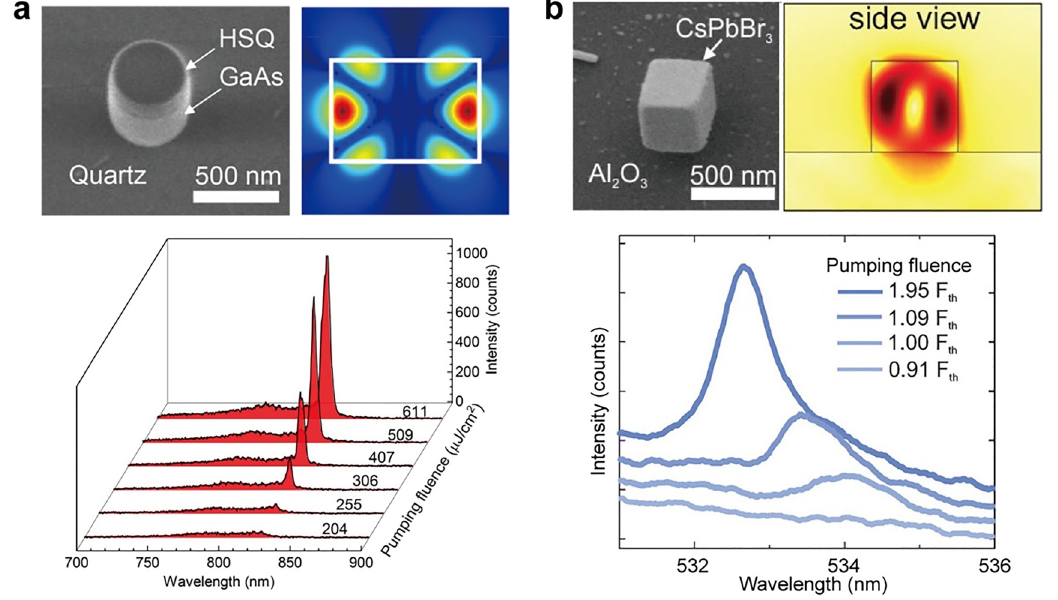
Figure 2: Two recent demonstrations of the Mie-resonant nanolasers. (a) Scanning electron image (SEM) of GaAs nanoscale cylinder covered by hydrogen silsesquioxane resist (HSQ) (top left). Calculated electric near-field distribution of the cylinder at the lasing wavelength (top right) and evolution of the emission spectrum of the resonator with diameter 500 nm and height 330 nm at different pumping fl uence (bottom) (adopted from Ref. [23]). (b) SEM image of CsPbBr 3 perovskite nanocube (top left), calculated electric near- fi eld distribution at the lasing wavelength (top right), and evolution of the emission spectrum of the perovskite nanocube with the side length of 310 nm at different pumping fl uence (bottom) (adopted from Ref.